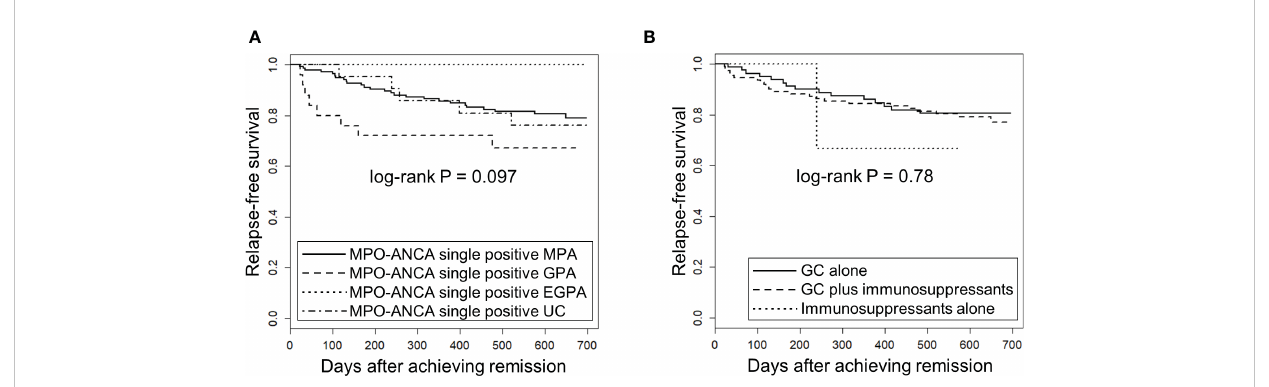
FIGURE 2 Relapse-free survival in MPO-ANCA single-positive AAV patients according to the EMA classi fi cation and treatment modality. The longitudinal and horizontal axes represent the probability of relapse-free survival and days after achievement of remission, respectively. P value was calculated by log-rank test. (A) Relapse-free survival was compared among MPO-ANCA single-positive, MPA (n=141), GPA (n=25), EGPA (n=12) and unclassi fi able AAV (UC) (n=21). Note that PR3-ANCA positive patients are not included in any group. (B) Relapse-free survival was compared among MPO-ANCA single-positive AAV patients treated with glucocorticoid (GC) alone (n=84), GC plus immunosuppressants (n=112) and immunosuppressants alone